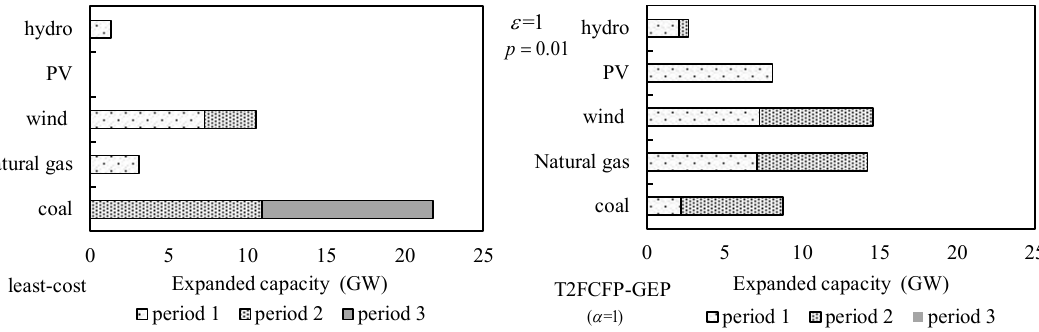
Figure 12. Comparison of capacity expansions from two models.